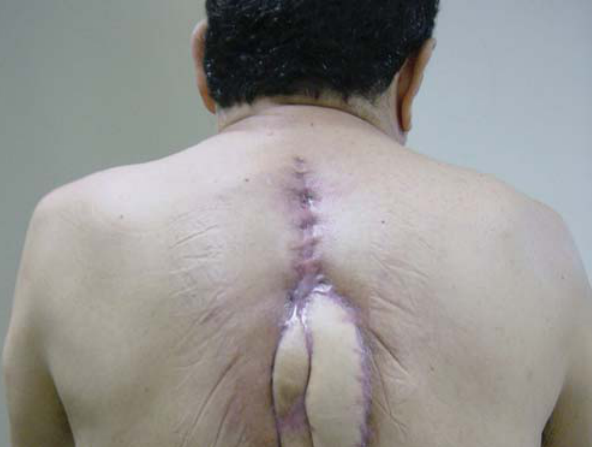
Figure 5 - Final aspect of the healed wound after rotation of the right latis- simus dorsi musculocutaneous flap